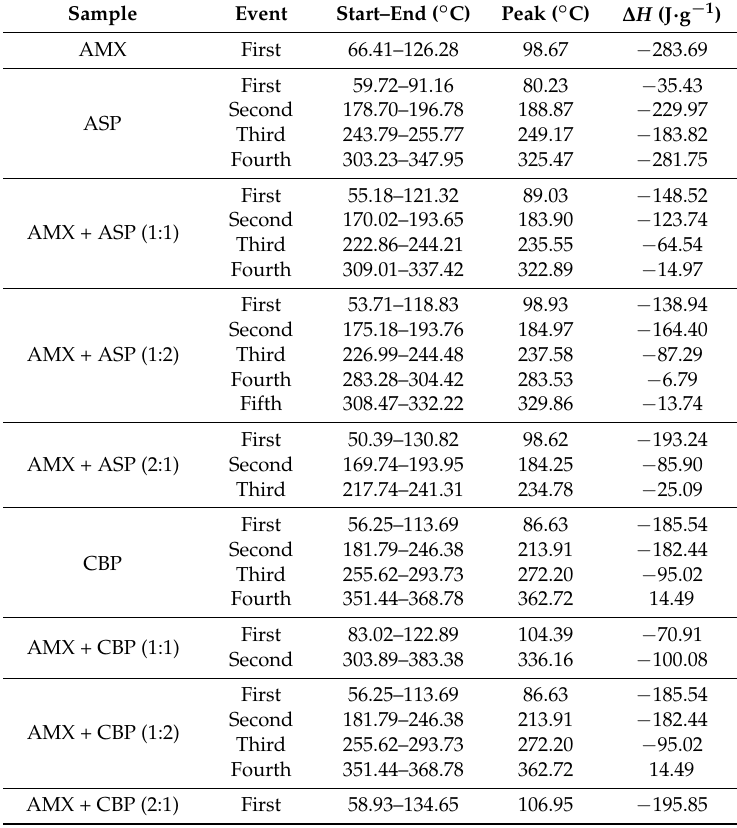
Table A2. DTA data of AMX, excipients, and their binary mixtures at 1:1, 1:2, and 2:1 proportions (AMX: